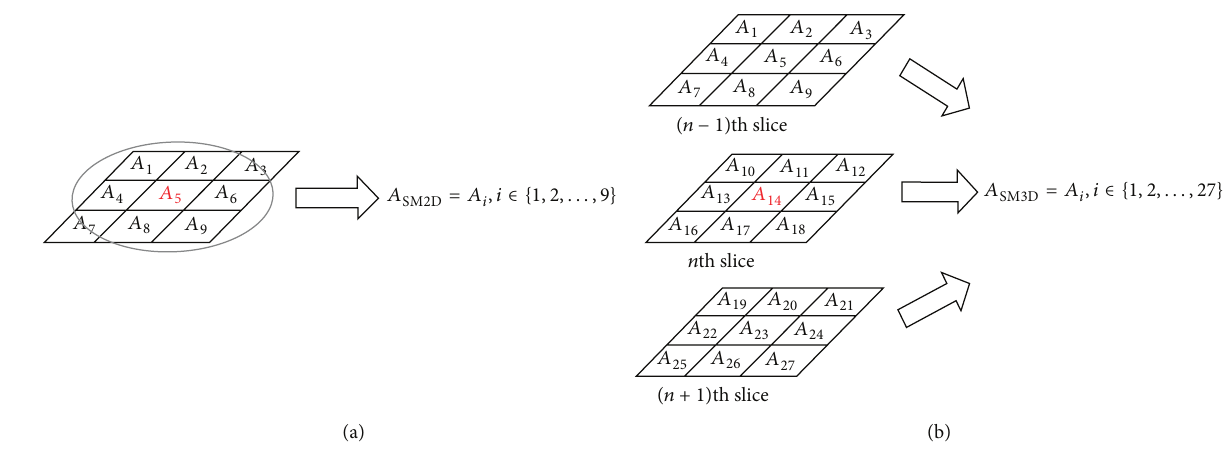
Figure 1: Computations of (a) SM2D and (b) SM3D